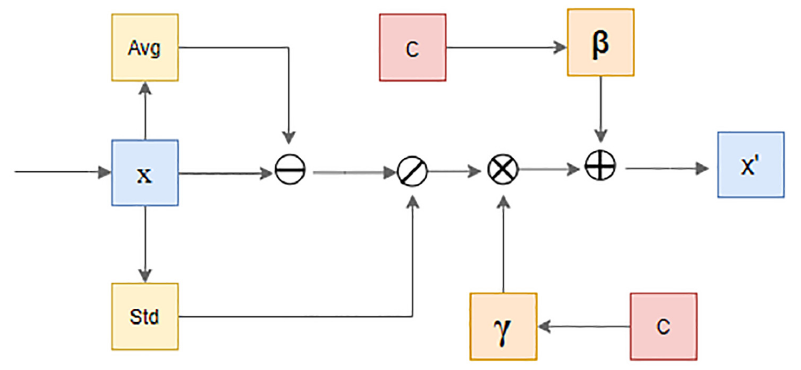
Figure 3. BiLSTM structure.